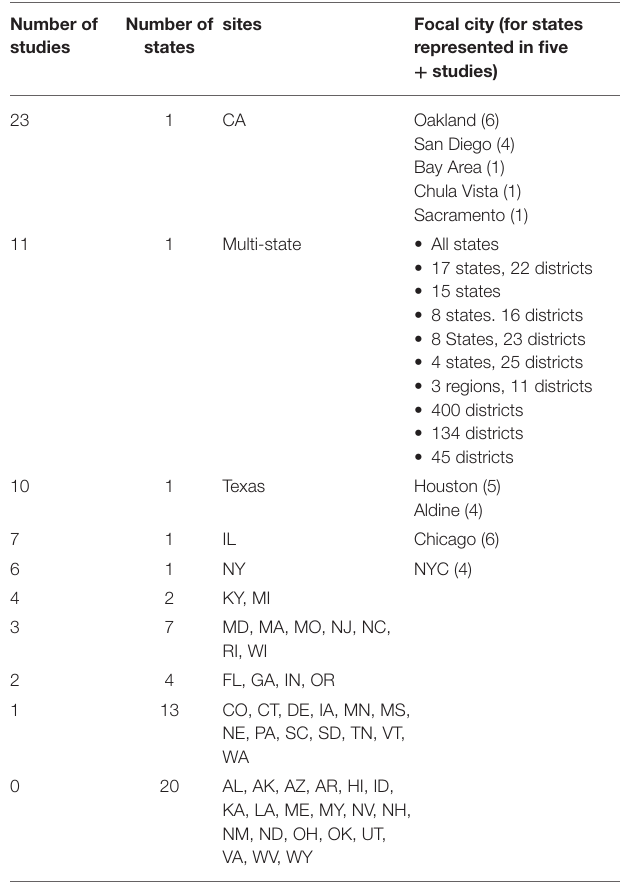
TABLE 6 | States represented in the review sample and the frequency of inclusion. Number of Number of studies